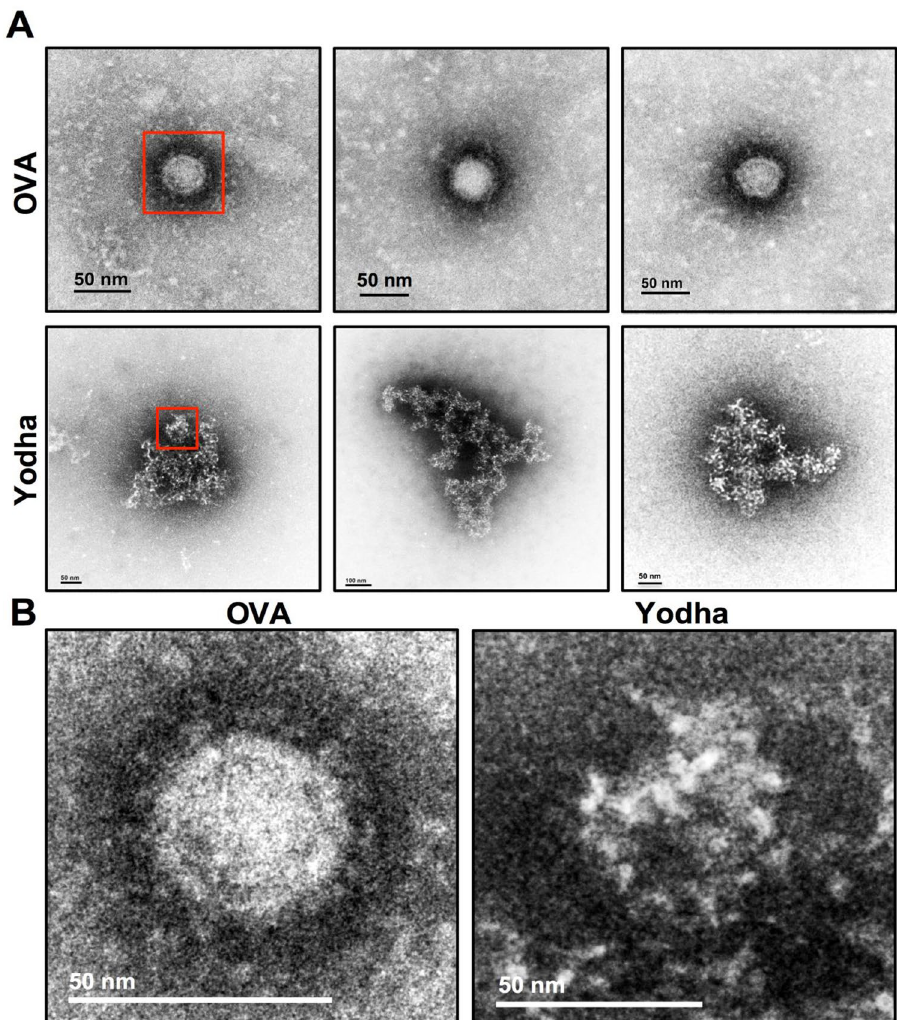
Figure 3. Transmission electron microscopy shows that Yodha peptide destroys ZIKV. ( A ) TEM micrographs of ZIKV treated with OVA (control) or Yodha peptide are shown. ZIKV were incubated with the peptides at 200 µM for just 10 min, fixed with paraformaldehyde and then processed for electron microscopy. Yodha treatment led to loss of morphology and aggregation of virus particles. ( B ) Enlarged images of ZIKV treated with control or Yodha peptide from ( A ) are shown. The data is representative of three experiments